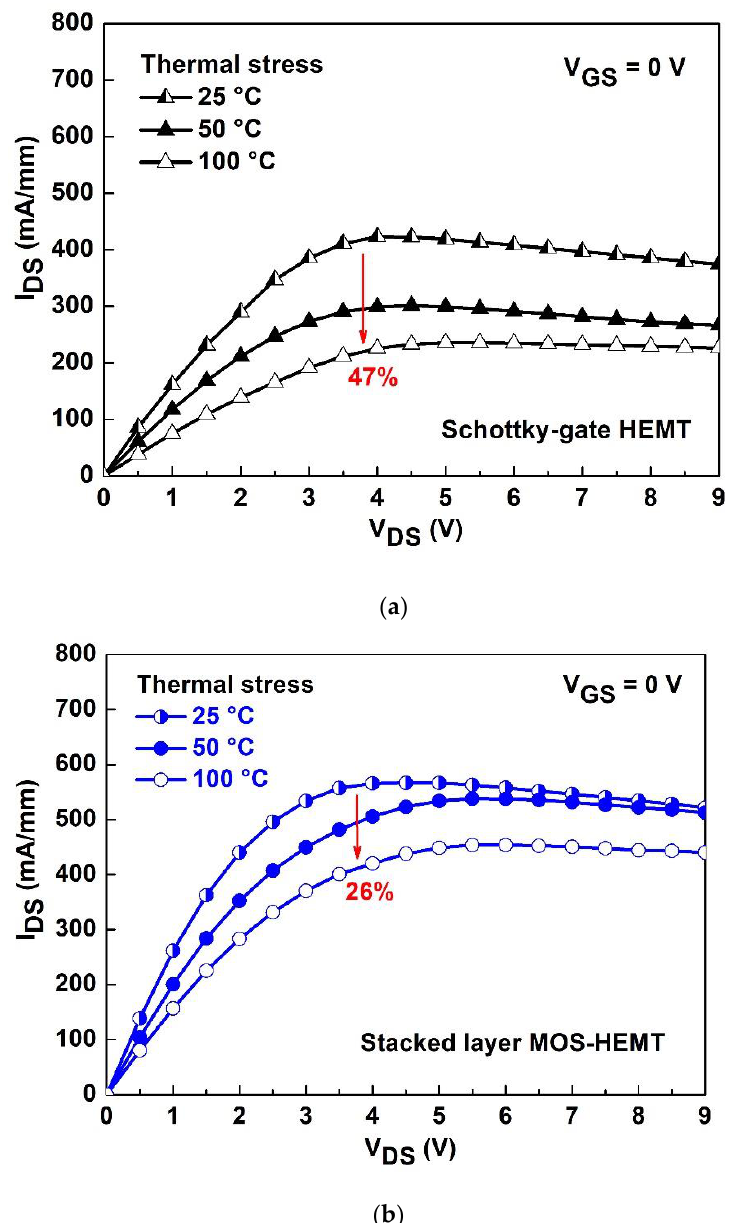
Figure 7. I DS -V DS characteristics with various temperatures ranged from 25 °C to 100 °C for ( a ) the Schottky-gate HEMT and ( b ) the stacked layer MOS-HEMT.